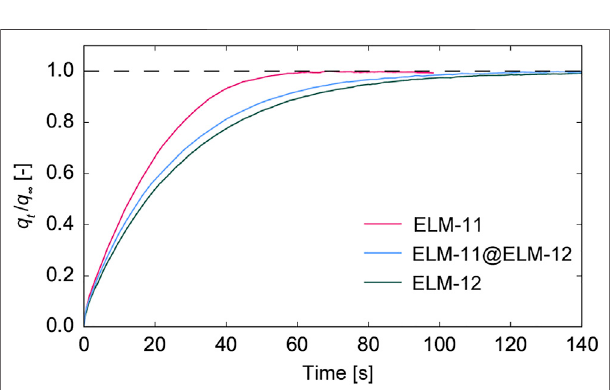
FIGURE 8 | Adsorption rates of water at 298 K in ELM-11, ELM-11@ ELM-12, and ELM-12 particles.